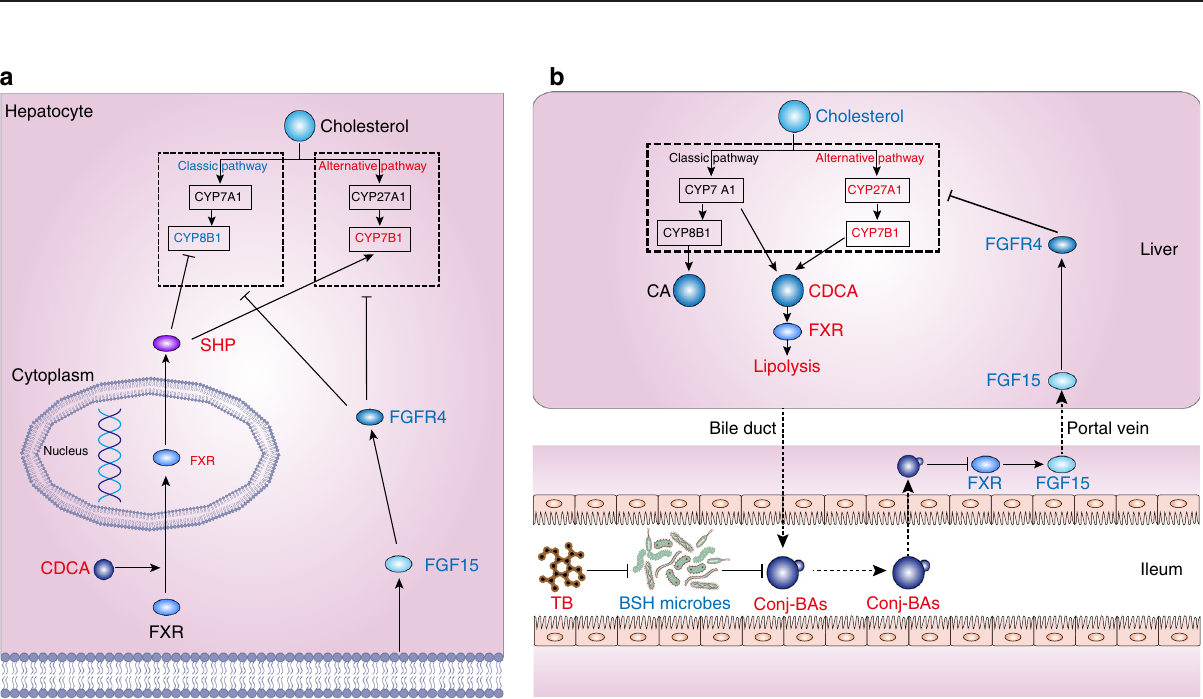
Fig. 8 Proposed mechanism for theabrownin reduce cholesterol level. a Theabrownin promoted alternative bile acids synthetic pathway by simultaneous inhibition of intestinal FXR-FGF15 signaling with TCDCA or TUDCA and activation of hepatic FXR-SHP signaling with CDCA.Intestinal FXR-FGF15 signaling inhibits hepatic bile acid synthesis genes CYP7A1, CYP8B1, CYP27A1 and CYP7B1 with no selectivity, whereas hepatic FXR-SHP signaling